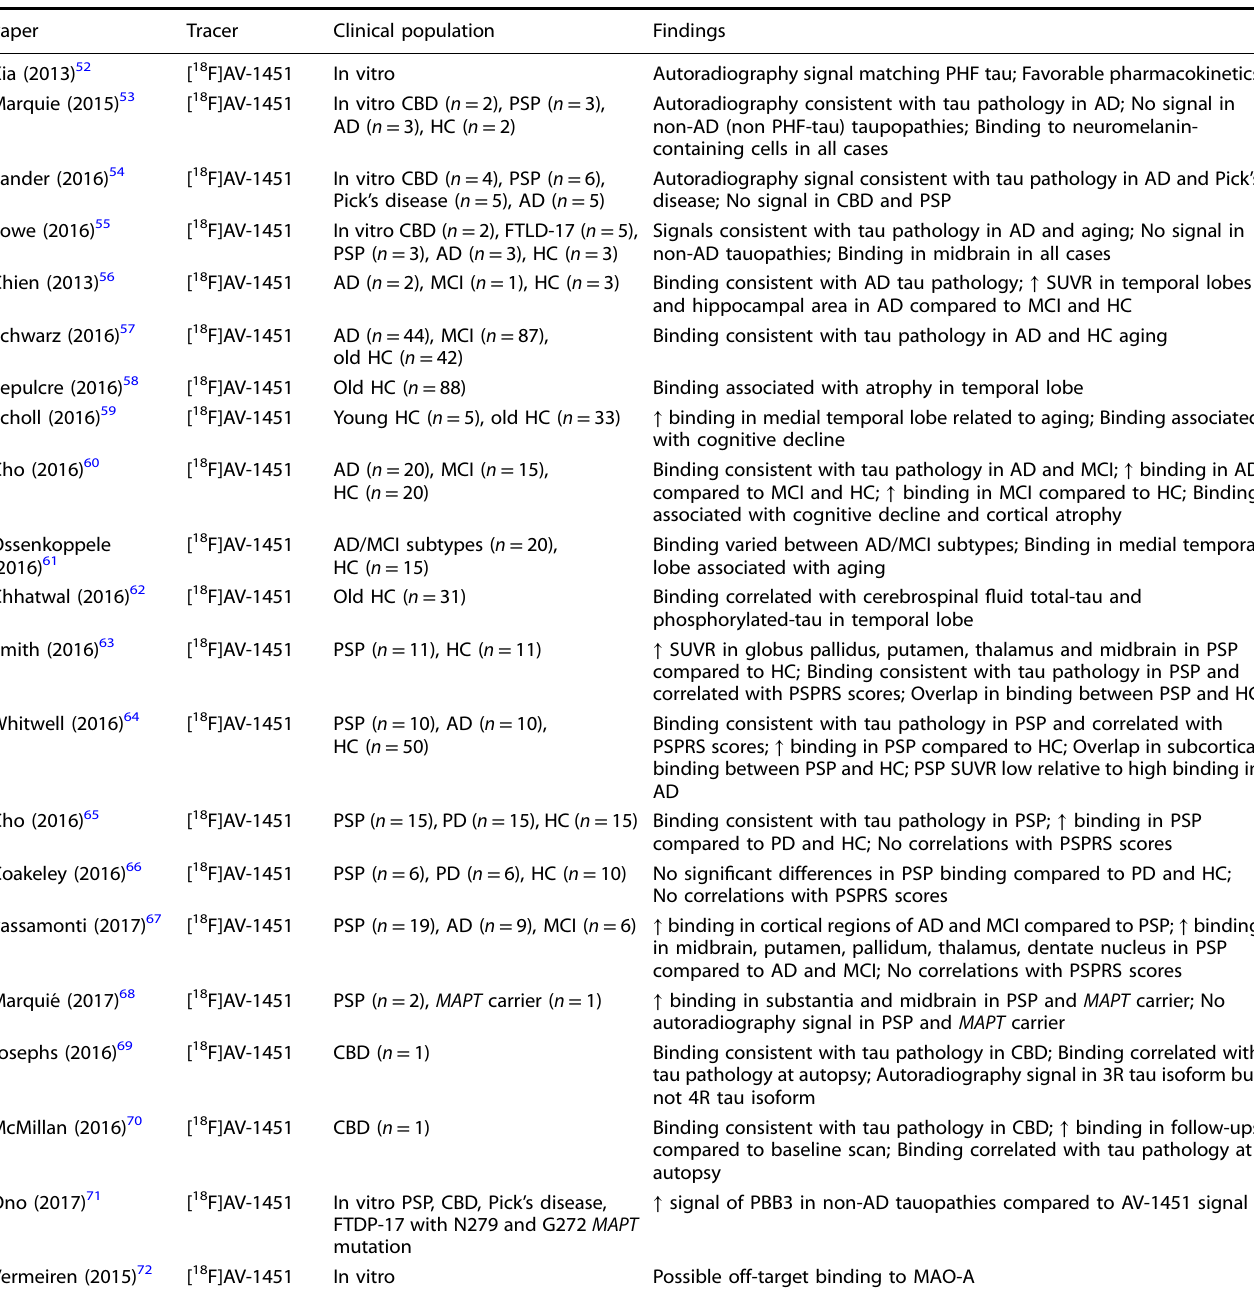
Table 4. Main fi ndings from PET tau studies using [ 18 F]AV-1451 Paper Tracer Clinical population